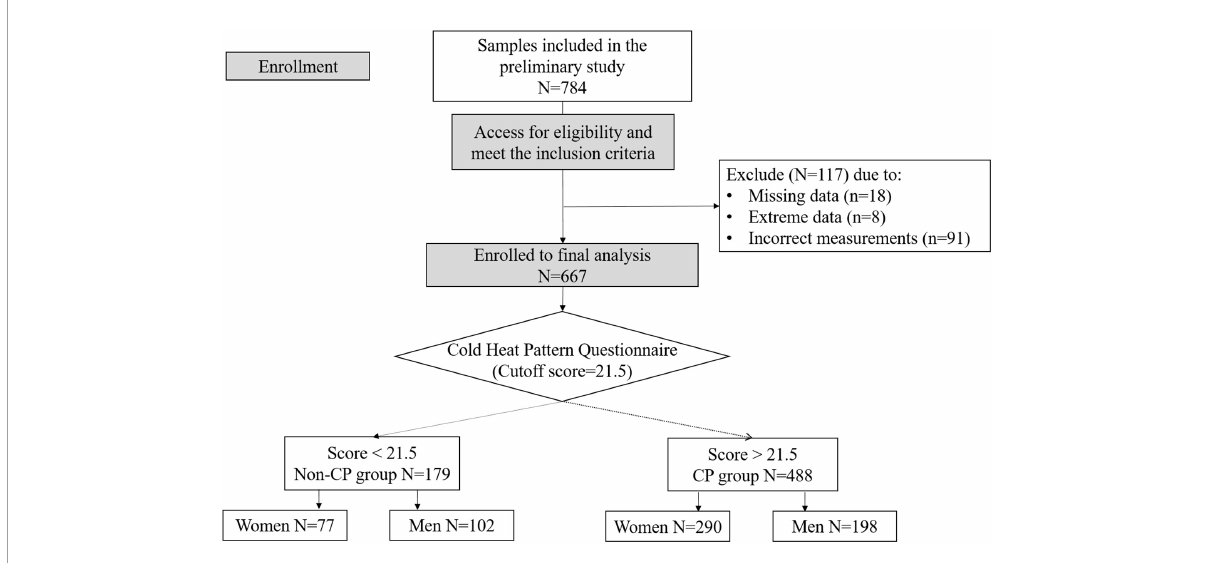
FIGURE2 Consolidated standards of reporting trials (CONSORT) diagram illustrating enrollment and exclusion criteria for this study.